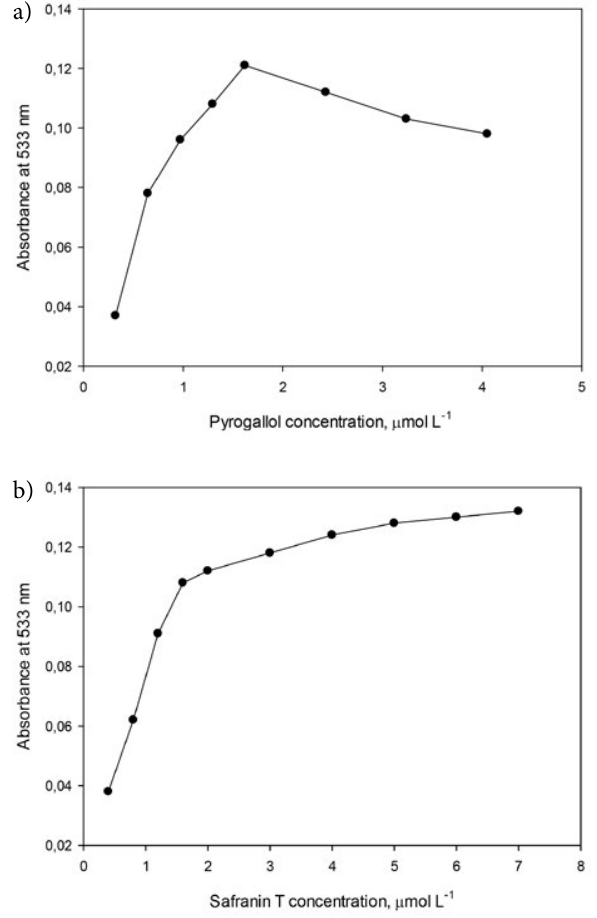
Figure 2. The influence of (a) pyrogallol concentration and (b) sa- franin T concentration at pH 6.0 on the analytical signal. Condi- tions: 50 μg L –1 V(V), 0.8 mmol L –1 B-R buffer at pH 6.0, 6.0 mmol L –1 KCl solution, and 0.05% ( w/v ) Triton X-114 at 50 °C and incuba- tion for 3